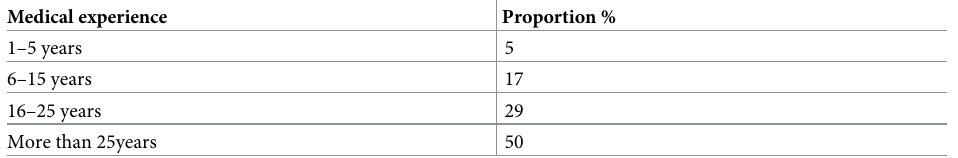
Table 2. Characteristics of medical expert informants’ experience.